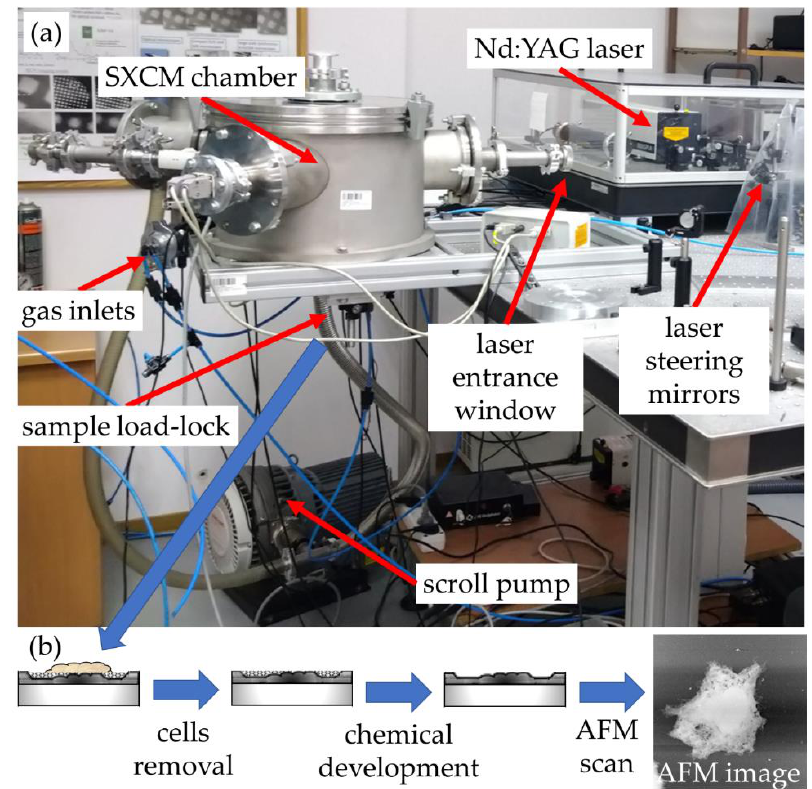
Figure 1. ( a ) Soft X-ray contact microscopy (SXCM) system and ( b ) the flowchart of the SXCM sample-processing procedure.